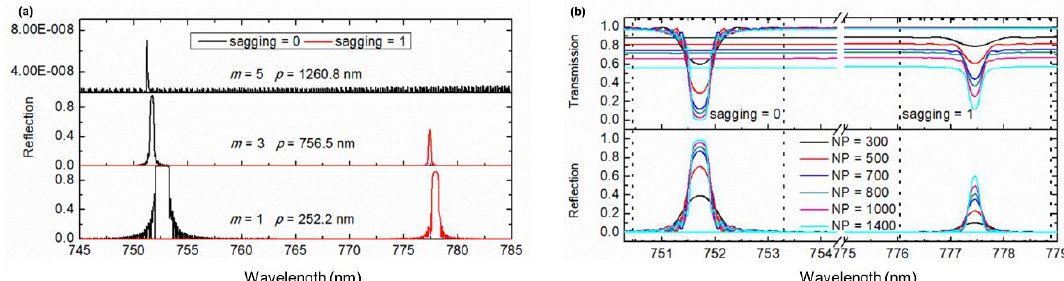
Figure 4. ( a ) Reflection spectra of the first, third and fifth order Bragg gratings consisting of a strip waveguide of 700 nm × 50 nm and periodic pillars of 110 nm tall with the same total grating length in the two extreme cases of sagging = 0 and sagging = 1; ( b ) Dependences of the reflection spectra and the transmission spectra on the number of period NP.